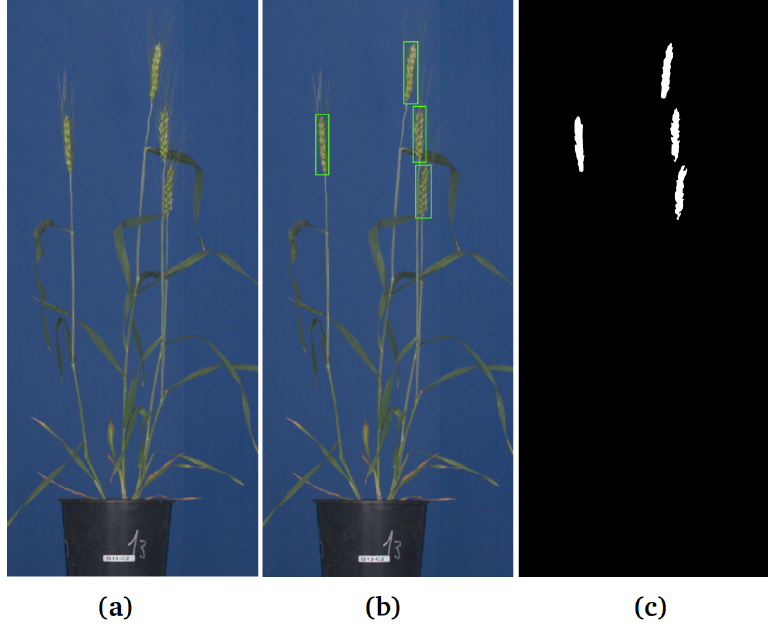
Figure 1. Example of spike detection and segmentation in greenhouse wheat images: ( a ) RGB visible light image of a matured wheat plant, ( b ) detection of spikes by rectangular bounding boxes, ( c ) pixel-wise segmentation of